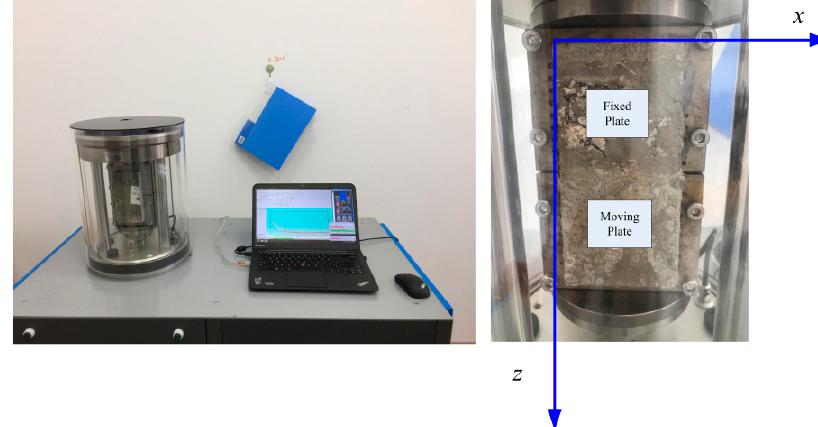
Figure 3. Installment of specimen.